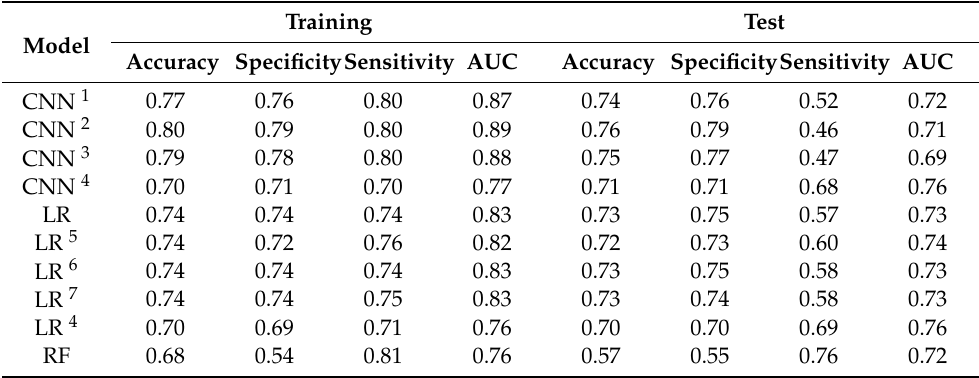
Table 4. Predictive ability of the CNN, LR, and RF models.